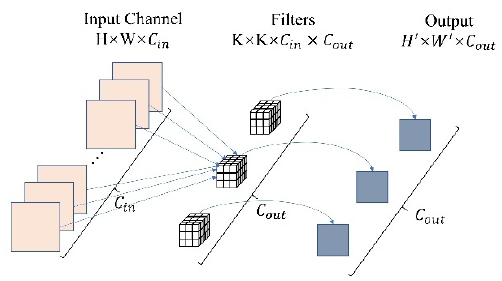
Figure 6. The conventional convolution feature extraction process.